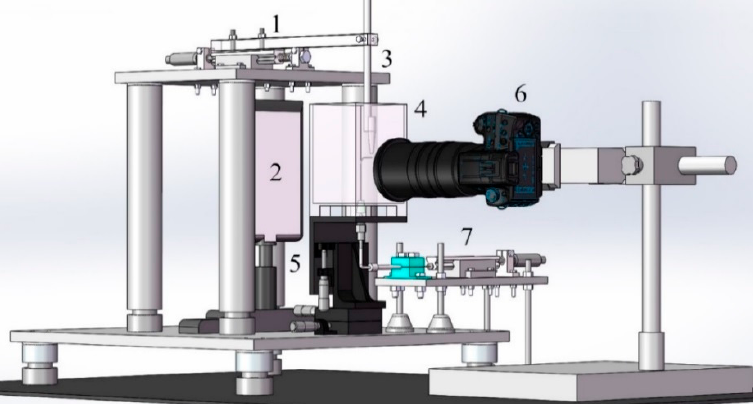
Figure 1. Three-dimensional (3D) diagram of experimental apparatus: 1: funnel micromoving device; 2: light-emitting diode (LED) array light source; 3: feeding funnel; 4: water tank; 5: bubble micromoving device; 6: camera; 7: bubble-generating device.